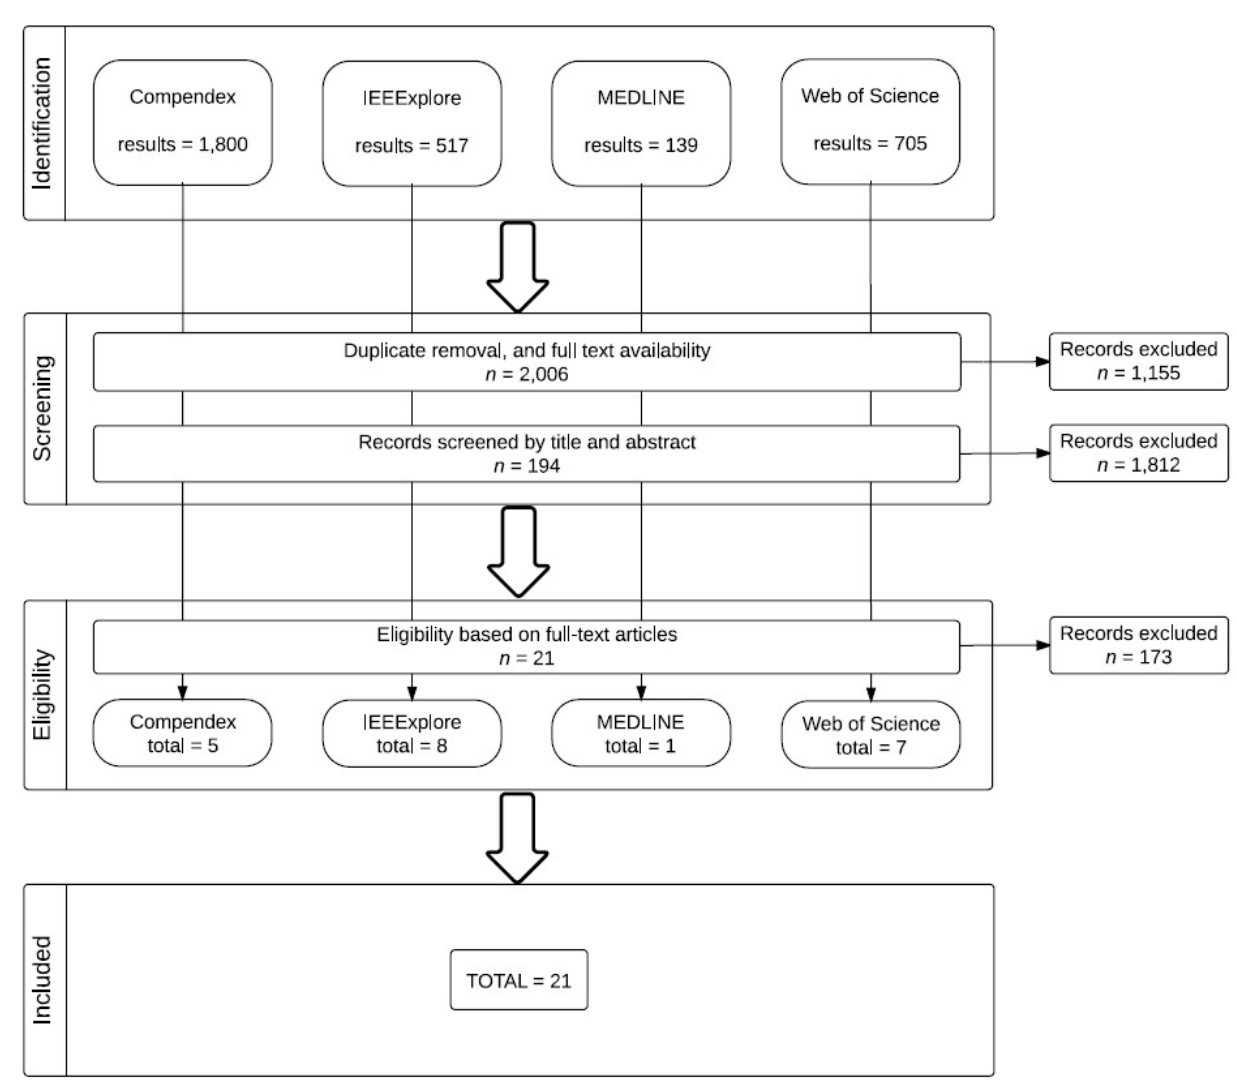
Figure 1. PRISMA flow diagram of this